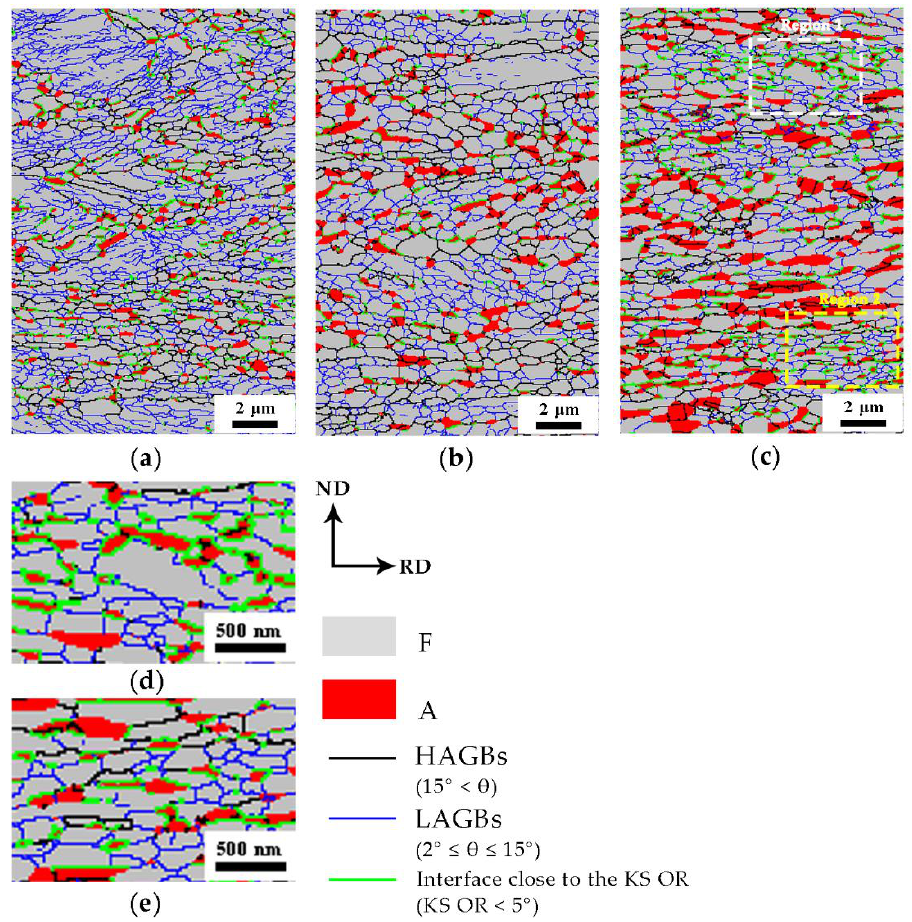
Figure 10. EBSD micrographs of samples ( a ) A650, ( b ) A675, ( c ) A700, ( d ) region 1 in ( c ), and ( e ) region 2 in ( c ).